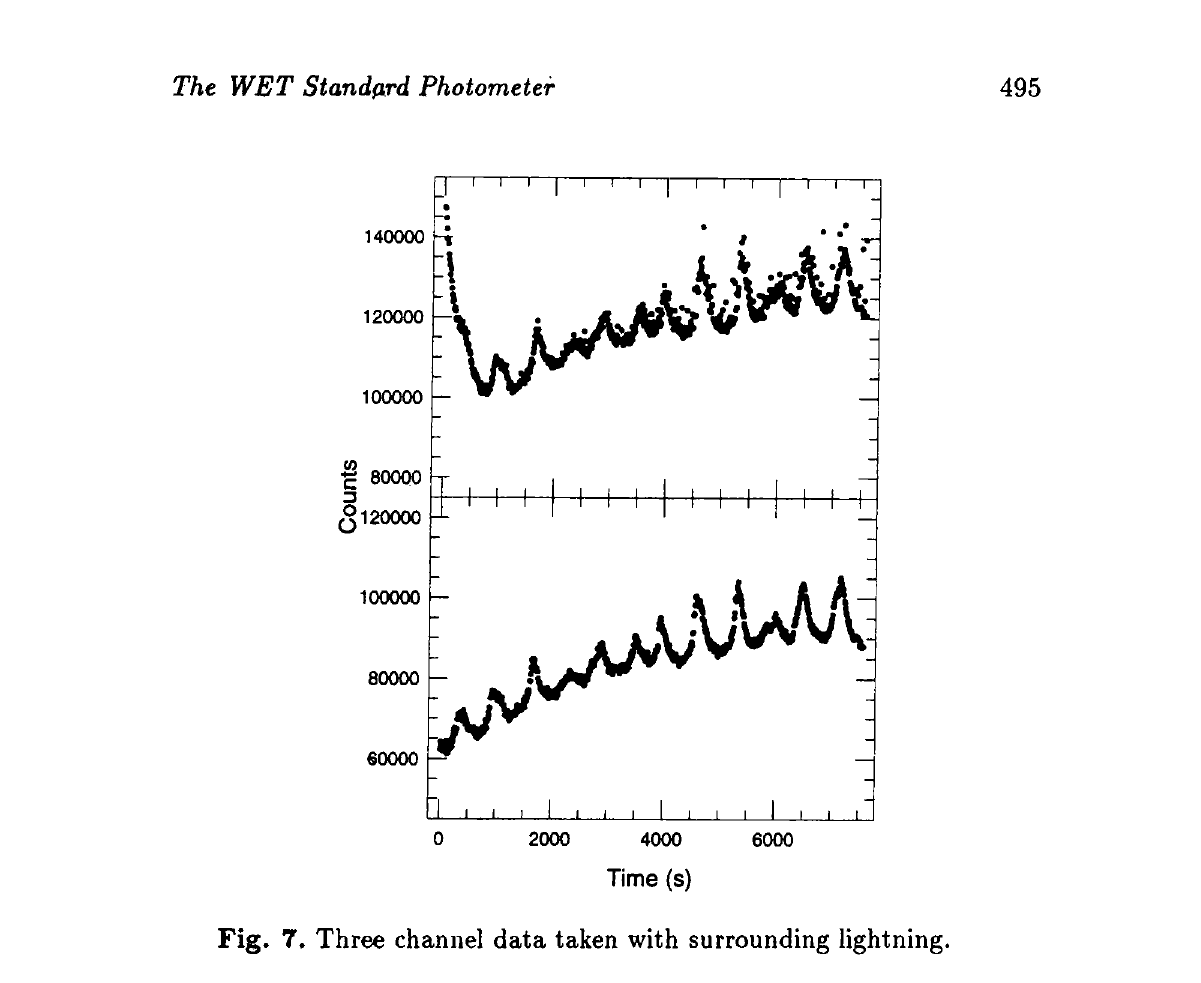
Fig. 7. Three channel data taken with surrounding